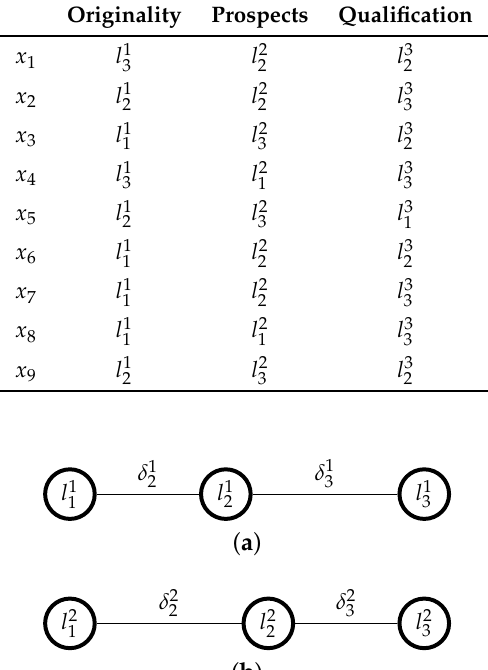
Table 11. Linguistic assessments for each criterion.